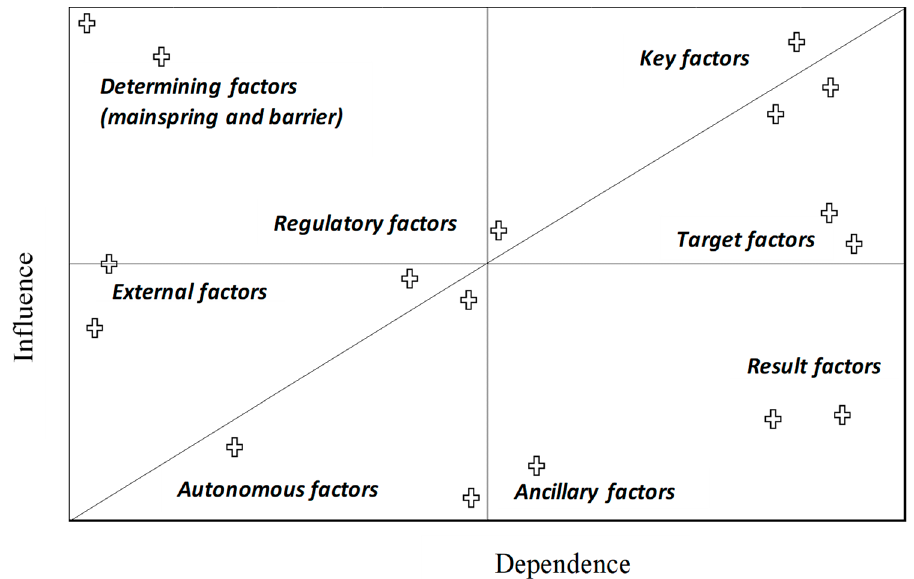
Figure 4. The system of influence–dependence factors within MICMAC (French acronym Matrice d'Impacts Croisés Multiplication Appliquée á un Classement , also known as Cross-Impact Matrix Multiplication Applied to Classification) method. Own study based on [29,30].